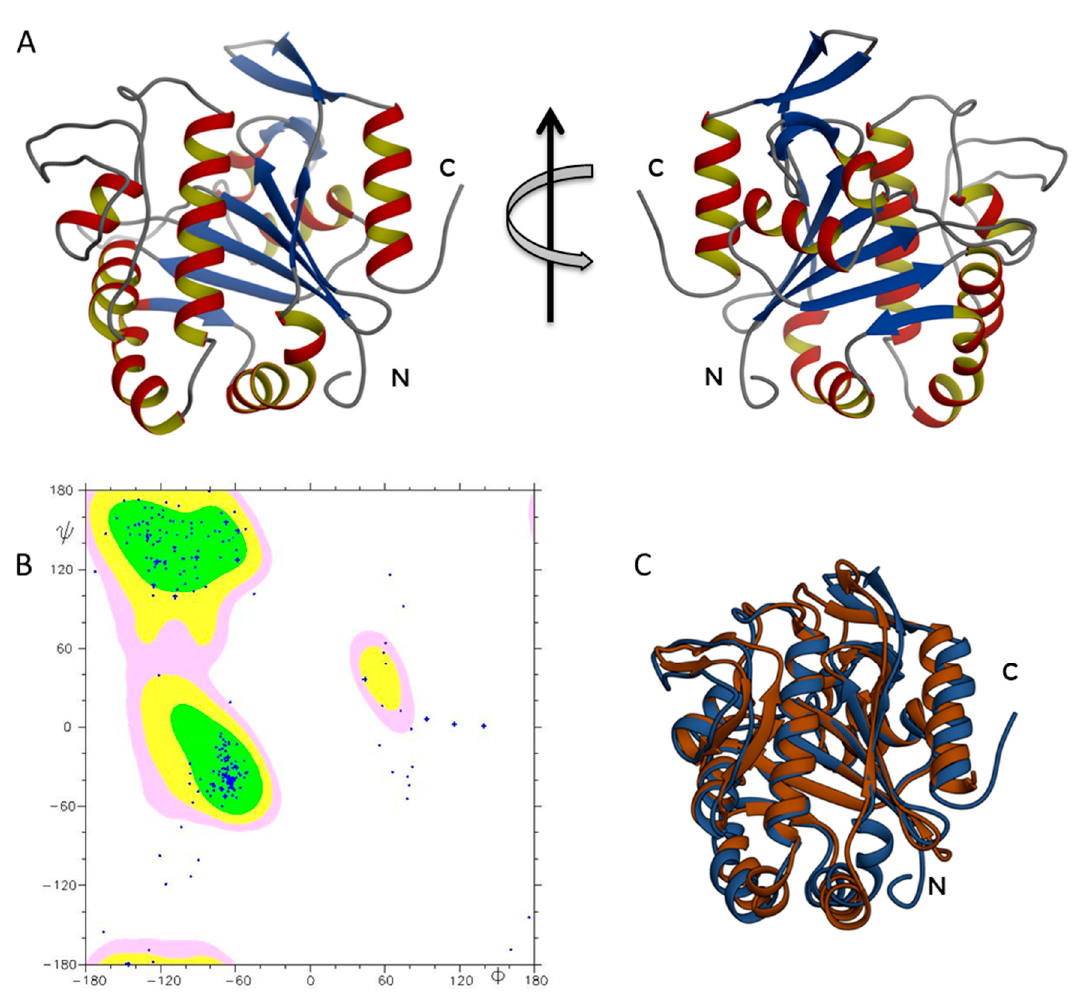
Figure 3. ( A ) Δ TM-FlmC structural model; ( B ) the Ramachandran plot confirms the good quality of Δ TM-FlmC predicted model; ( C ) Δ TM-FlmC superimposition with the crystallographic structure of Cps2A.